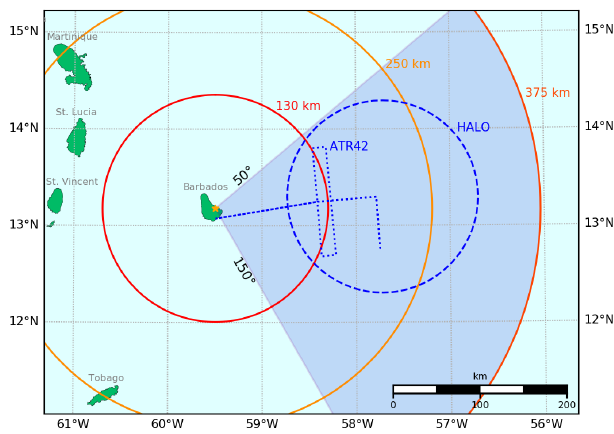
Figure 1. Coverage of the EUREC 4 A experimental area by Poldirad (blue shaded sector). Blue lines represent the typical flight pattern of the German HALO (dashed) and French ATR-42 (dotted) research